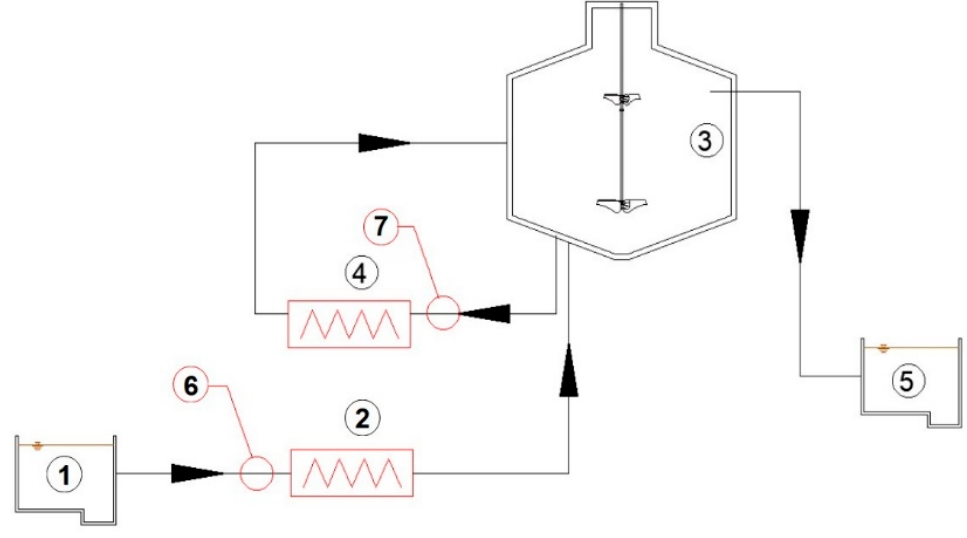
Figure 1. Flow sheet of sludge digestion in Silute WWTP: 1—Tank of sludge mixture, 2—Heat exchanger, 3—Digester, 4—Heat exchanger, 5—Tank of digested sludge, 6—Sampling point of sludge mixture, 7—Sampling point of inoculum.